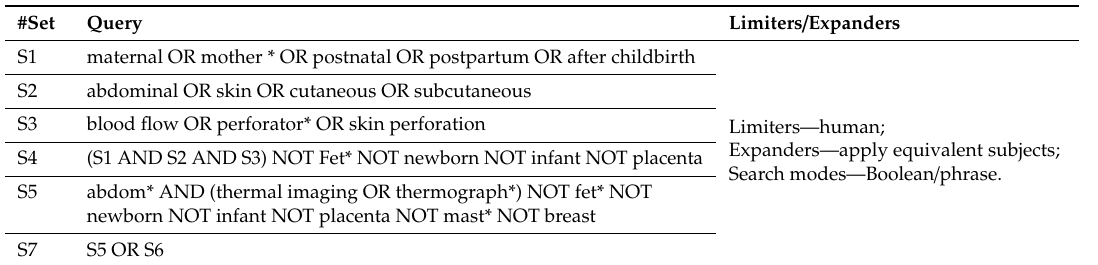
Table A1. Boolean operators under four facets “maternal OR postpartum”, “abdominal skin”, “blood flow or perforators” and “thermal